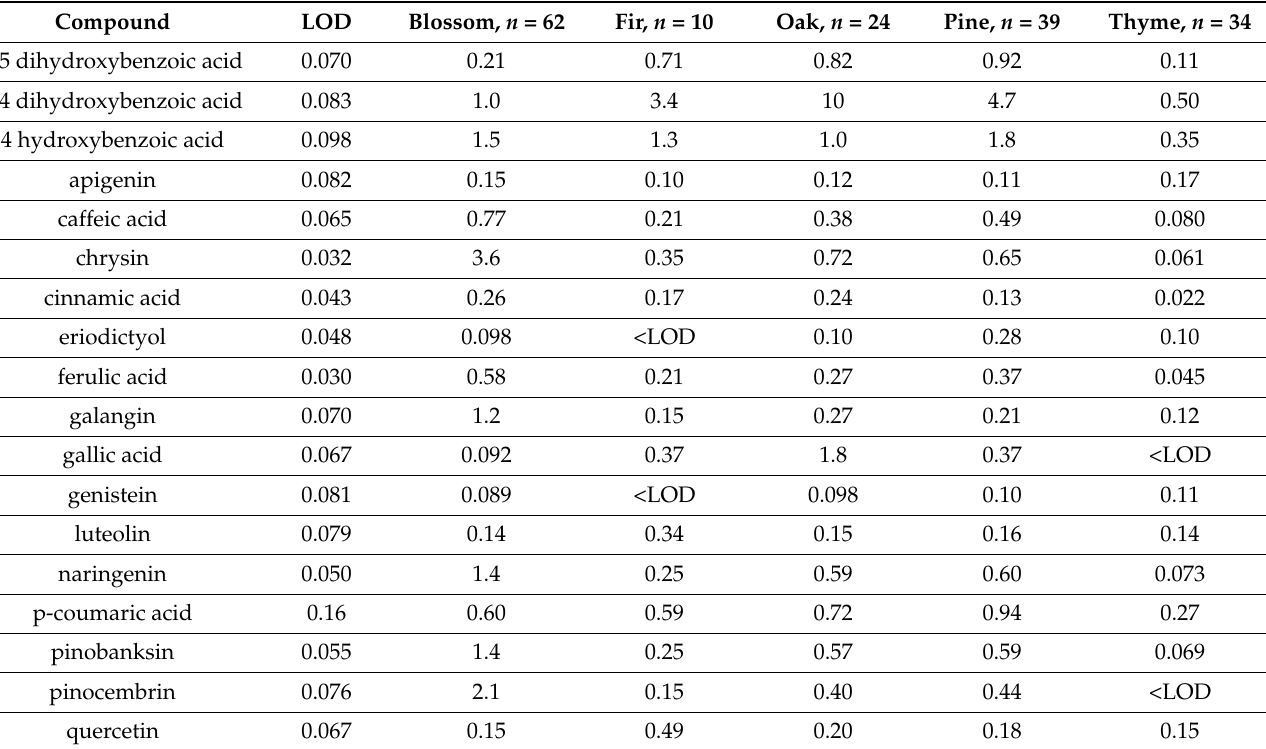
Table 1. Targeted screening results expressed as median concentration (mg kg − 1 ) of phenolic com- pounds in the 5 different honey